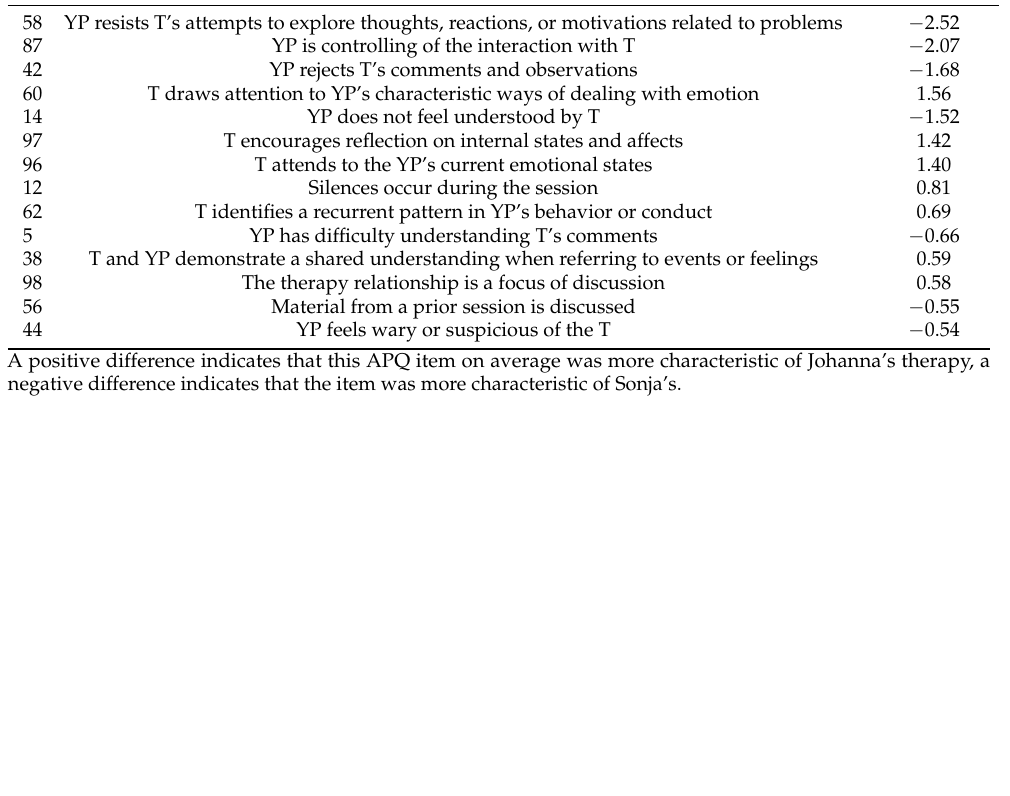
Table 3. Interaction structure differences measured in Z-scores on APQ Items describing the interac-